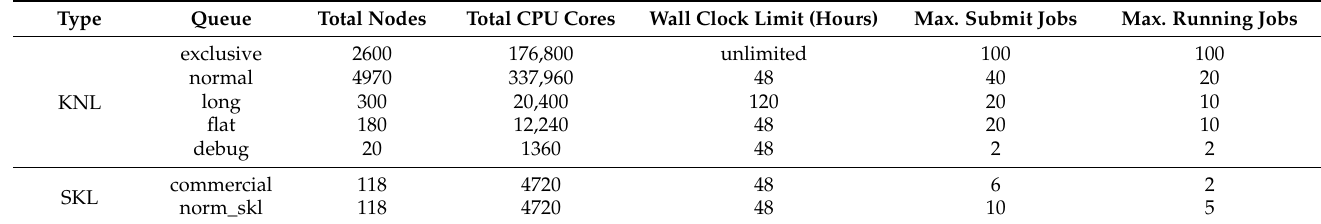
Table 1. Job-submit policies by